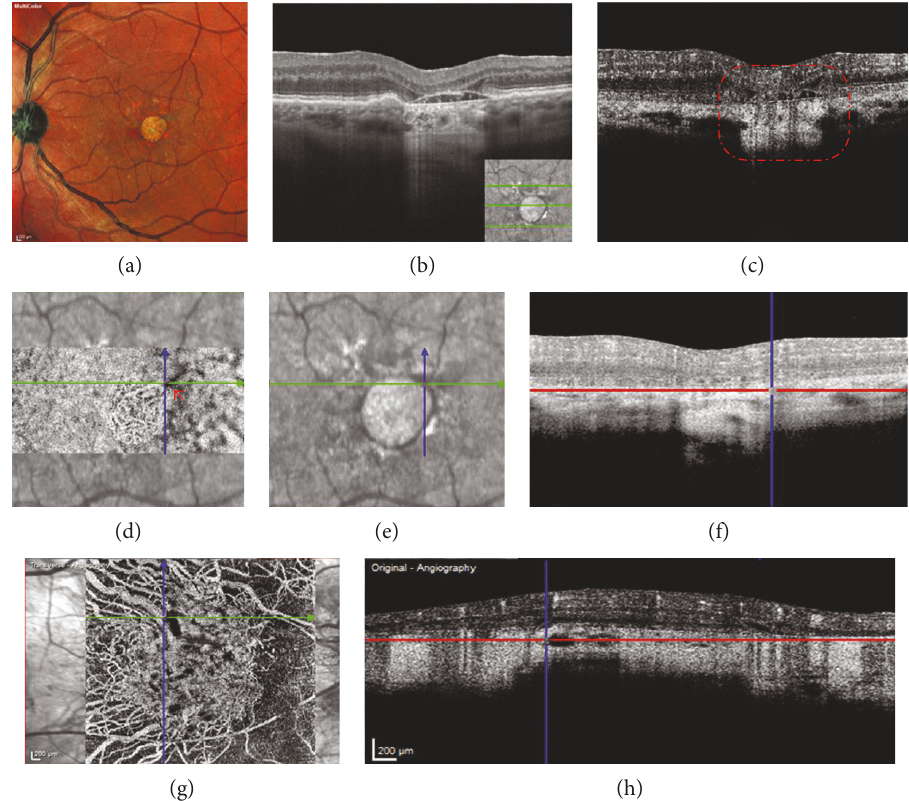
Figure 1: Increased penetration depth of scanning laser in a case of retinal pigment epithelium atrophy. (a) Multicolour images showed a round subfoveal atrophic RPE lesion. (b) SD-OCT shows collapse of the outer retina, atrophy of the choroidal capillaries and RPE, and increased penetration (the inserted image indicates the orientation of OCT scanning). (c) Cross-sectional OCTA at the same location shown in (b) con fi rms atrophy of the choroidal capillaries and enhances signals in the deep choroidal vasculature (red dash-dotted box). (d) En face OCTA shows a choroidal vessel that is dark because of the masking e ff ect of the RPE and choroidal capillaries (red arrow). (e) An infrared image con fi rms that the transition between light and dark vascular signal is at the atrophy margin. (f) Cross-sectional OCTA shows a corresponding hypointense halo (red arrow). (g) En face OCTA of another case showing a hypointense halo in the atrophic region with hyperre fl ective vascular signals. (h) Corresponding cross-sectional OCTA con fi rming the hypore fl ective halo without masked e ff ect, which needs to be explained by other mechanisms. OCTA: optical coherence tomography angiography; RPE: retinal pigment epithelium; SD-OCT: spectral-domain optical coherence